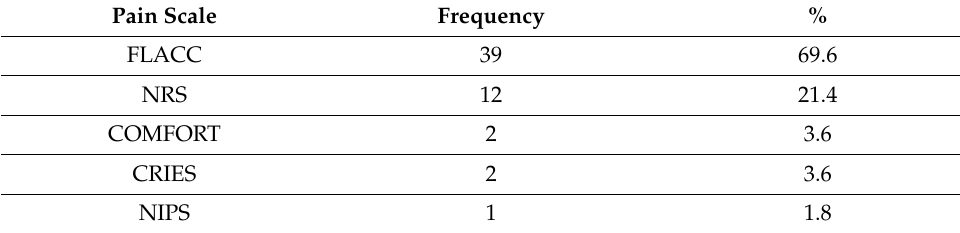
Table 3. Pain Assessment Scales